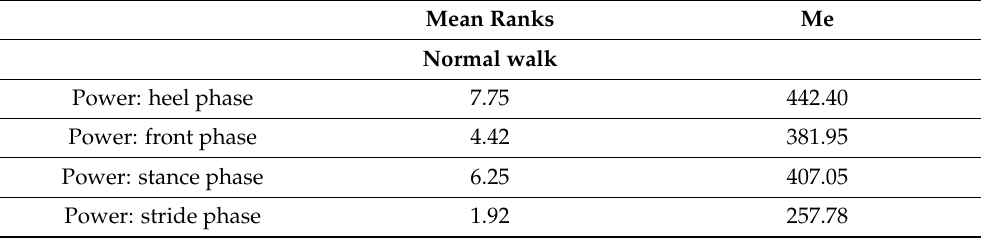
Table A3. Mean ranks with medians for analyzed